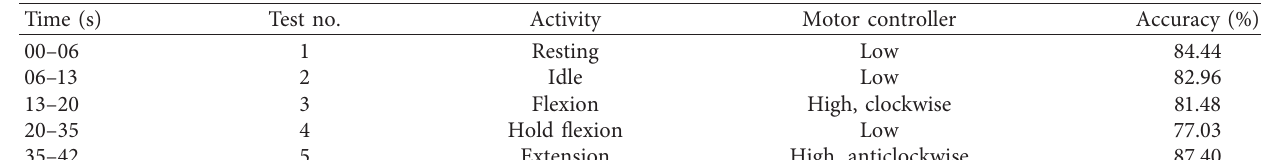
Figure 15: The ERD/ERS topographical view of the mu and beta frequencies during extension activity. Table 7: Finger movement vs. motor control behavior.